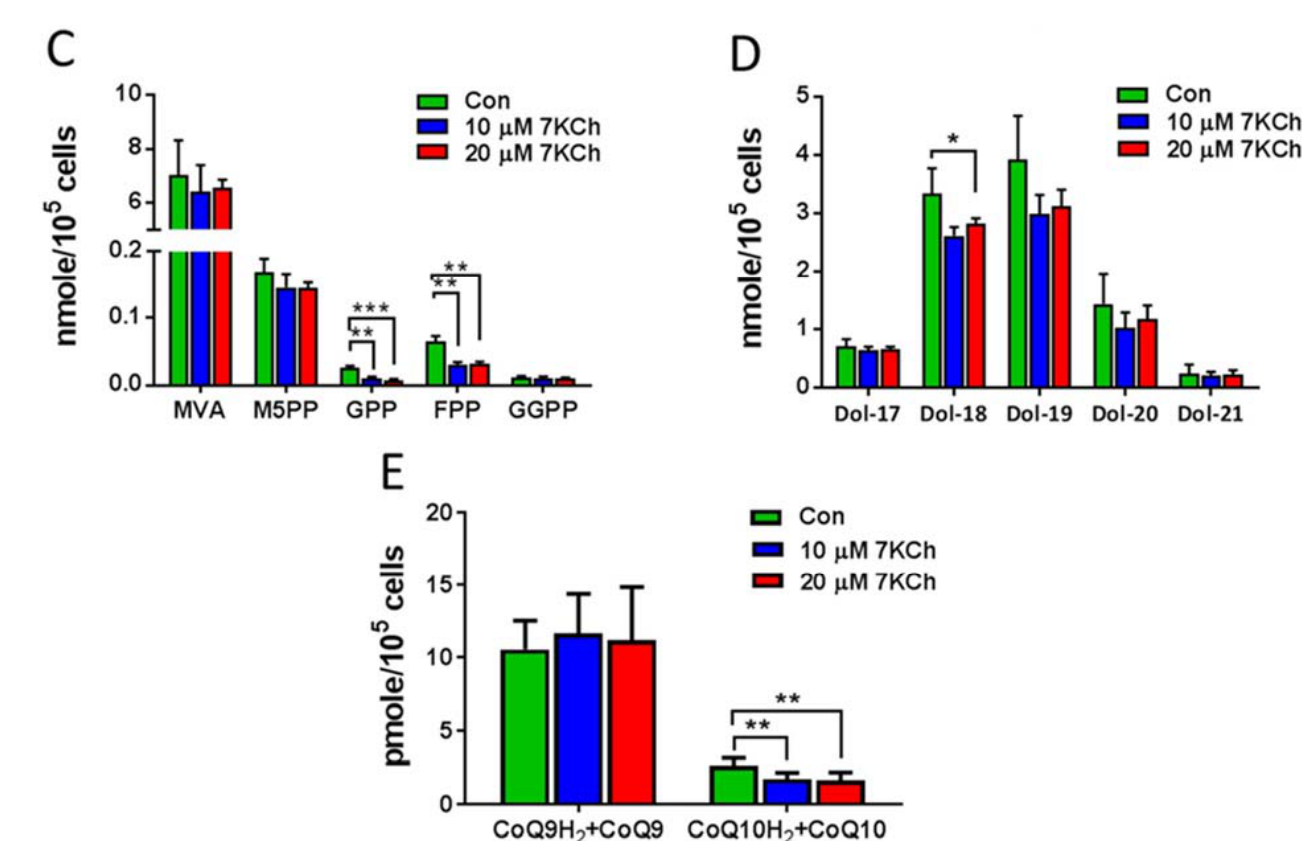
Figure 4. Effect of 7KCh on MVA pathway in cardiac cells. ( A ) A simplified diagram illustrating the mevalonate (MVA) pathway and its conversion to cholesterol, dolichol, coenzyme Q, and farnesyl-PP and geranylgeranyl-PP. Genes marked in blue represent the downregulated genes after 7KCh treatment, while those marked in red represent the upregulated ones. ( B ) Changes in expression 7KCh levels of MVA pathway-related genes in HL-1 cells treated with 20 µ M 7KCh for 24 h are shown as the fold change (log ) 2 Con (cid:16) Expression units ( in FPKM ) of the gene in 7KCh − treated cells (cid:17) that is indicative of log for the specified gene. The differentially changed genes 2 Expression units ( in FPKM ) of the gene in control ( Con ) cells include Hmgcs1 , Idi1 , Hmgcr , Mvk , Acat2 , Mvd , Pmvk , Fdps , Pcyox1 , Coq2 and Dhdds (adjusted p value < 0.05, n = 3). The accession number and descriptions of these genes are given in Supplementary Table S1. ( C – E ) HL-1 cells were untreated ( Control ) or treated with indicated concentrations of 7KCh for 24 h and harvested for LC-MS/MS-based determination of intermediates in the MVA pathway ( C ), dolichols ( D ), and CoQs ( E ). Data are mean ± SD of three experiments. * p < 0.05, ** p < 0.01, *** p < 0.001. Mevalonate, MVA; mevalonate-5-pyrophosphate, M5PP; geranyl pyrophosphate, GPP; farnesyl pyrophosphate, FPP; geranylgeranyl pyrophosphate, GGPP; Dolichol, Dol; coenzyme Q,